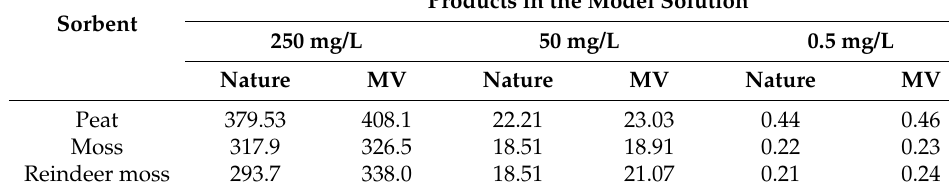
Table 4. The maximum sorption capacities.